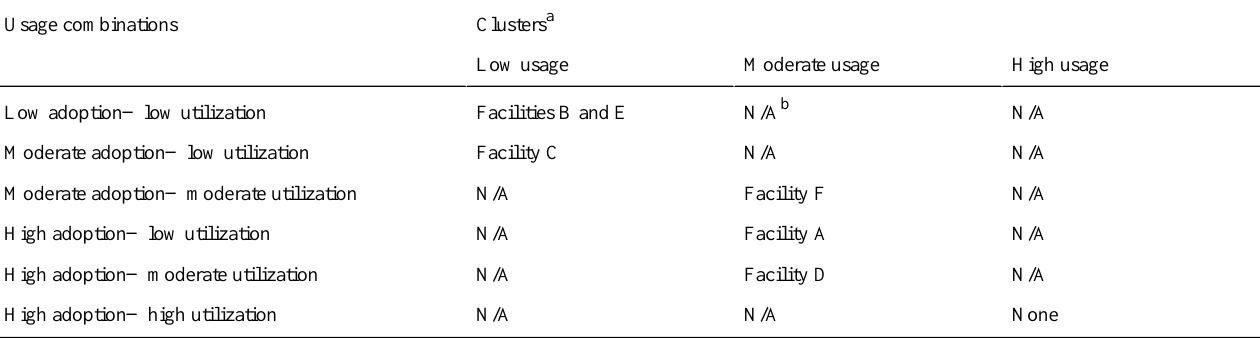
Table 2. Clustering of